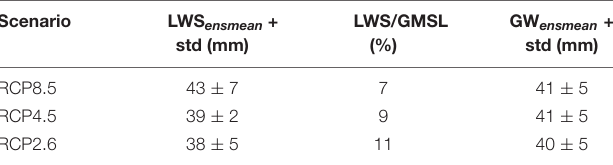
TABLE 1 | Ensemble mean LWS-driven GMSL rise including 1 sigma, over the twenty-first century and then header in the Table LWS LWS/GMSL and GW. Scenario LWS ensmean + std